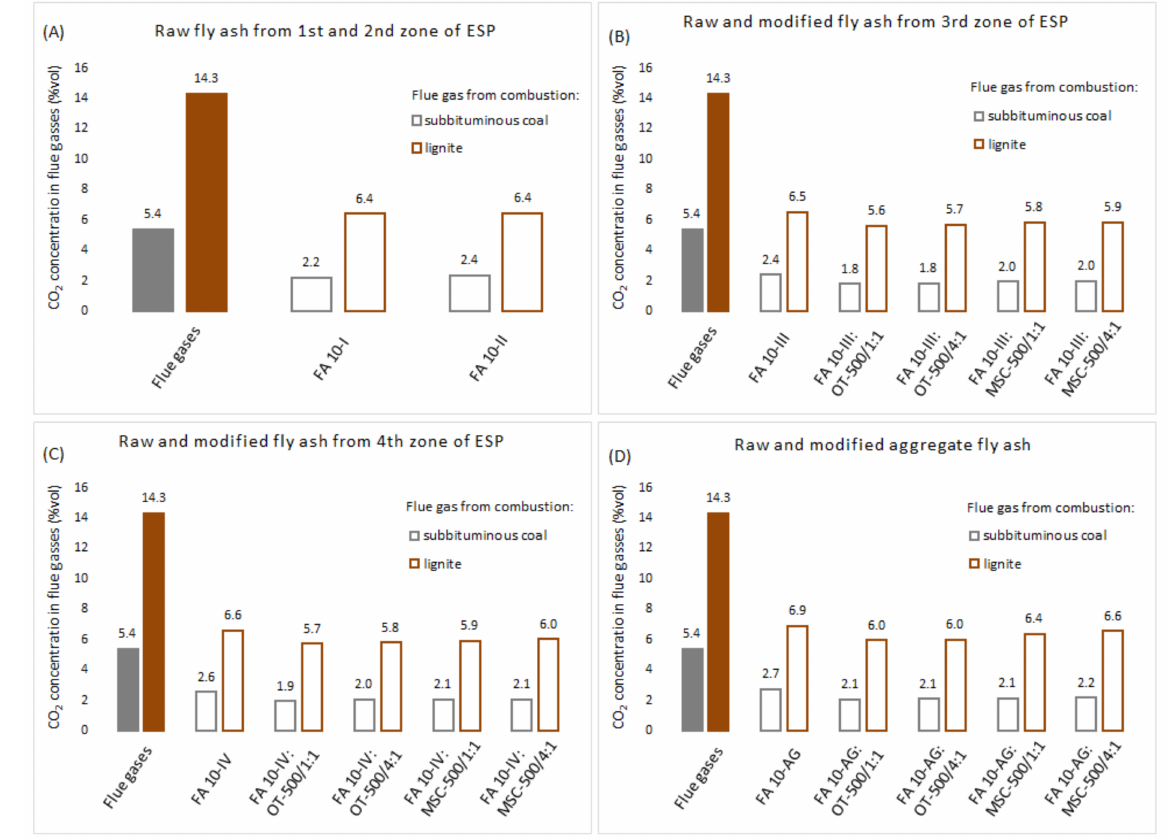
Figure 4. The concentration of carbon dioxide in raw flue gas and flue gases cleaned by FA and MFA from ( A ) 1st and 2nd zone, ( B ) 3rd zone, ( C ) 4th zone, ( D ) aggregate